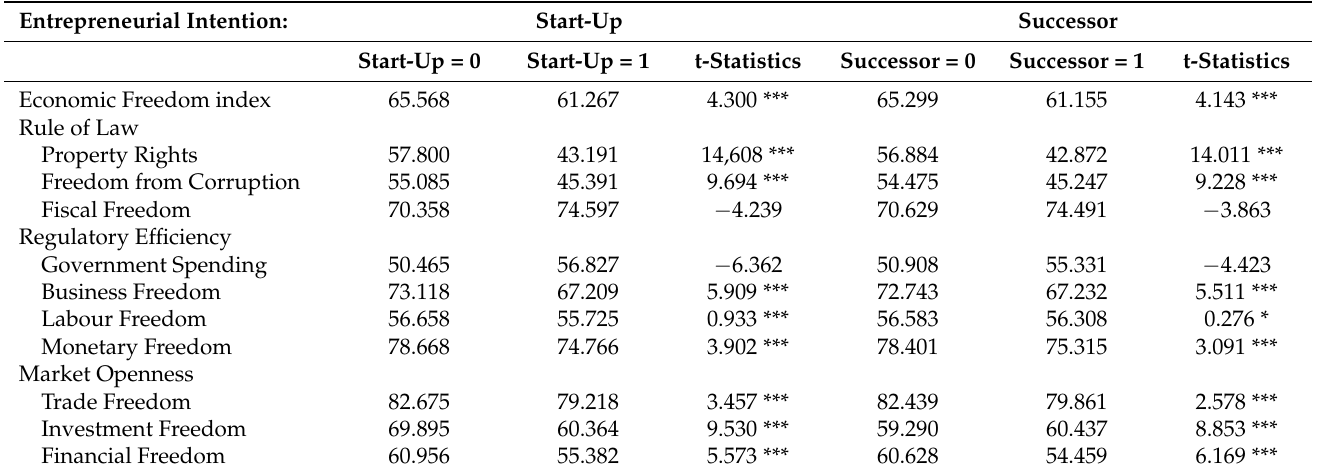
Table 5. Institutional dimensions and macro-economic characteristics by entrepreneurial intentions, on average, across the total